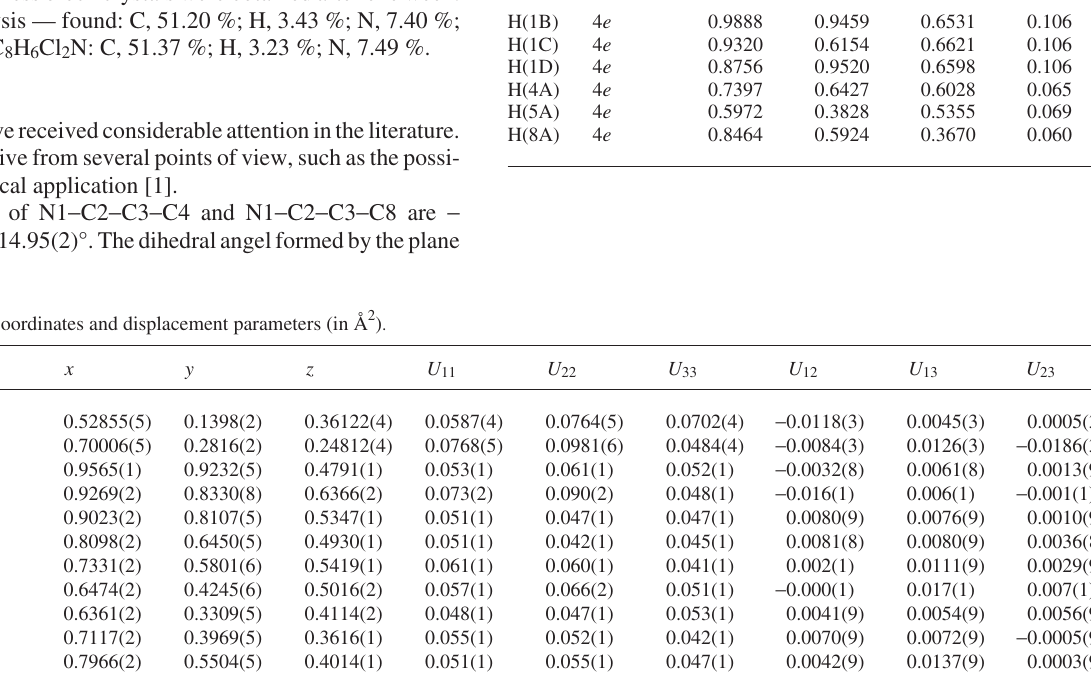
Table 2. Atomic coordinates and displacement parameters (in Å 2 ) .